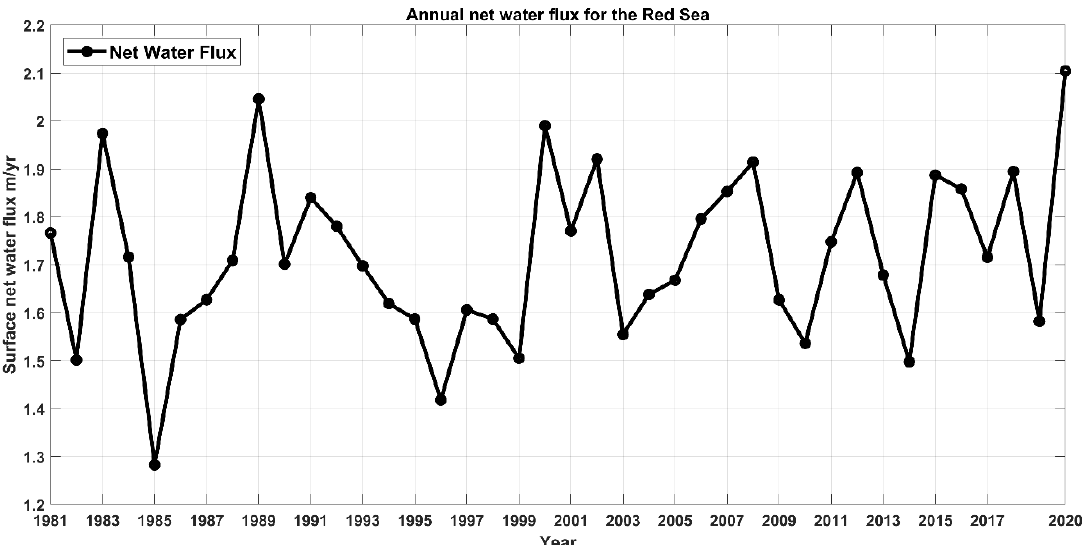
Figure 8. Annual surface net water flux (m/yr) time series for the Red Sea is denoted by a continuous black line from 1981 to 2020.